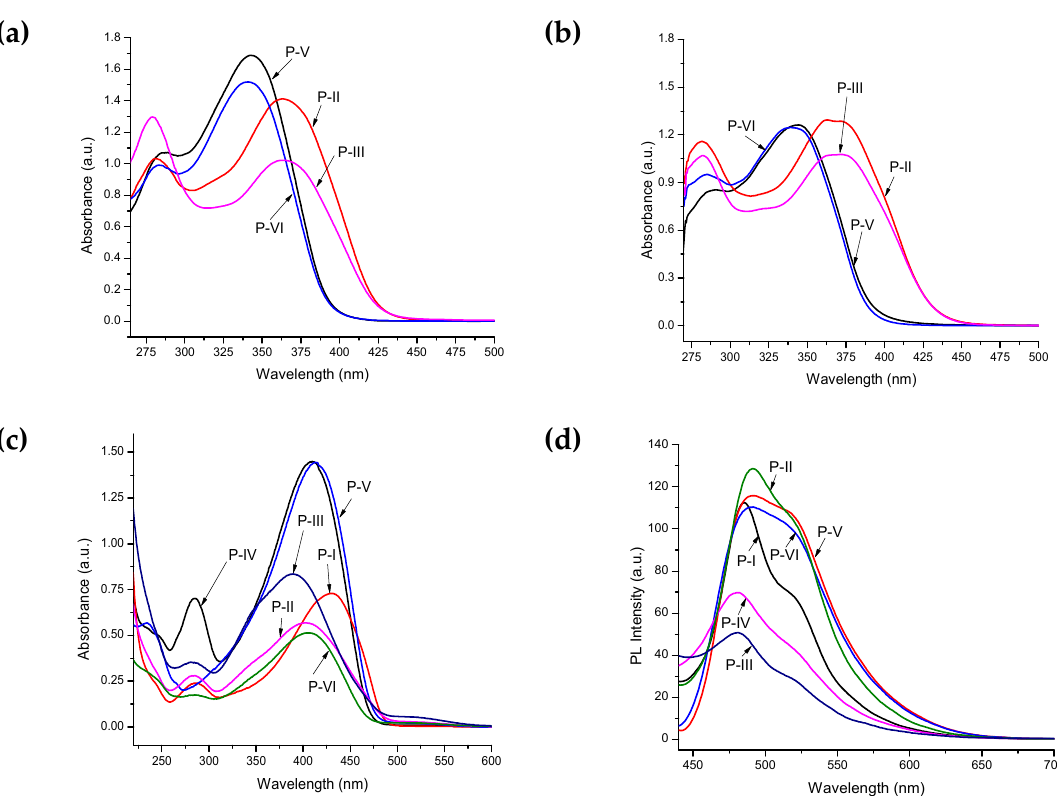
Figure 9. UV–vis spectra of dilute solutions of polyazomethines in ( a ) chloroform, ( b ) DMF, ( c ) sulfuric acid, and ( d ) photoluminescence spectra of polyazomethines using 420 nm as excitation wavelength. Table 1. Electronic absorption and photoluminescence data of polyazomethine polymers.